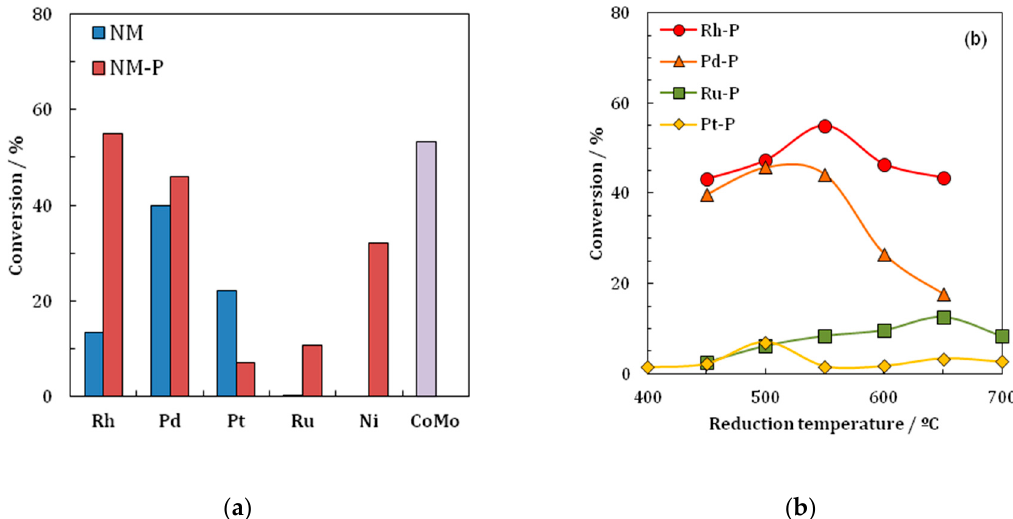
Figure 4. Results from the investigation of Kanda et al.: ( a ) Conversion values for the different catalyst materials reduced at optimal temperature; ( b ) Effect of the reduction temperature of the catalysts on the HDS conversion. Printed with permission of [29].